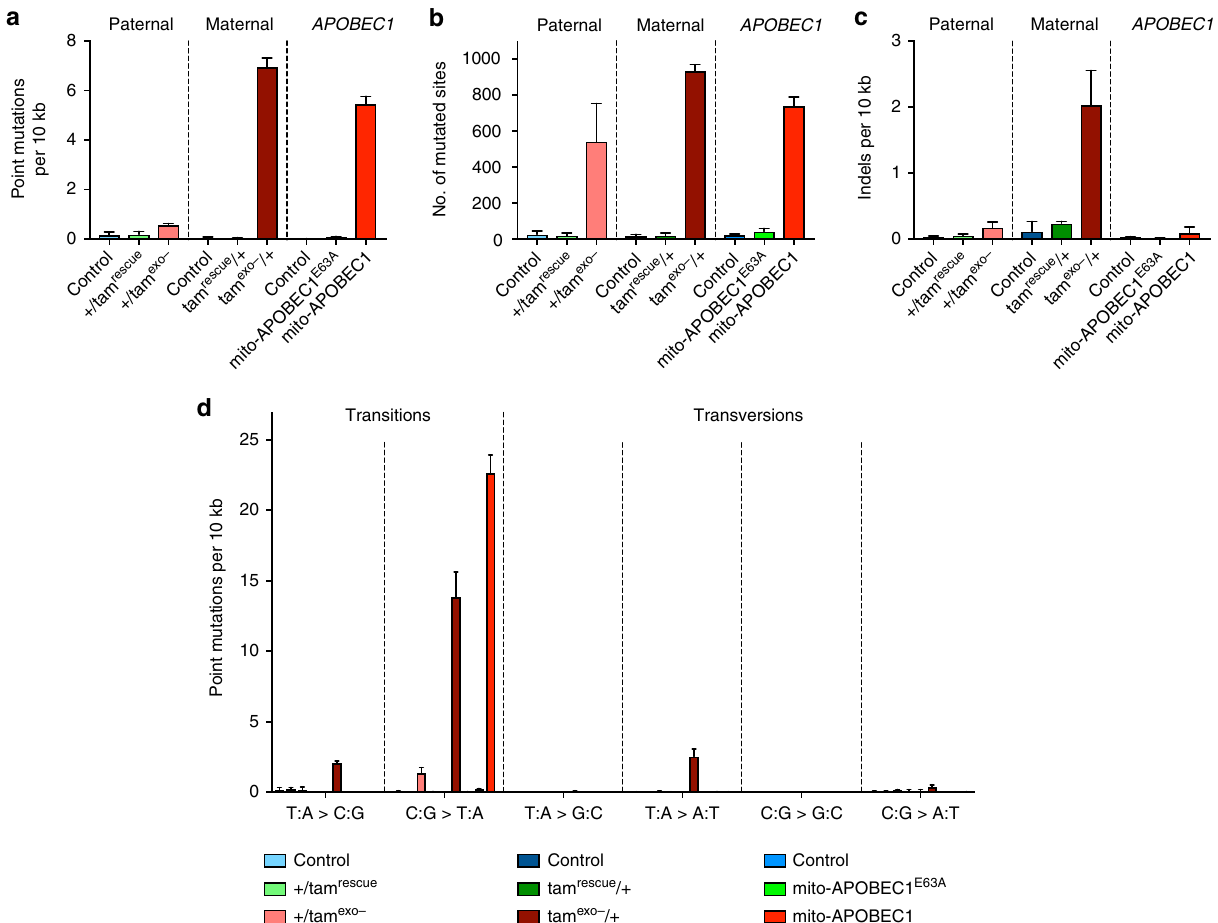
Fig. 1 Maternally inherited tam exo − and mito-APOBEC1 fl ies generate high mtDNA mutation level. Quanti fi cation of mtDNA mutations in 10-day-old paternally inherited tam exo − ( + / tam exo − ), maternally inherited tam exo − ( tam exo − / + ) and mito-APOBEC1 mutator fl ies and respective controls. a mtDNA mutation load, expressed as number of mutations observed, including heteroplasmic mutations, per total number of bases sequenced [Note that coverage at the non-coding A + T region, because of its repetitive high A:T content, is minimal and therefore, negligibly contributes to the overall mutation load], b the number of sites with at least one mutation, c indel mutation load, and d the mutation load identi fi ed by mutation type as indicated. Charts show mean ± SD, n = 3 animals per genotype. Full genotypes are given in Methods. Source data are provided as a Source Data fi le and Supplementary Data 1 and